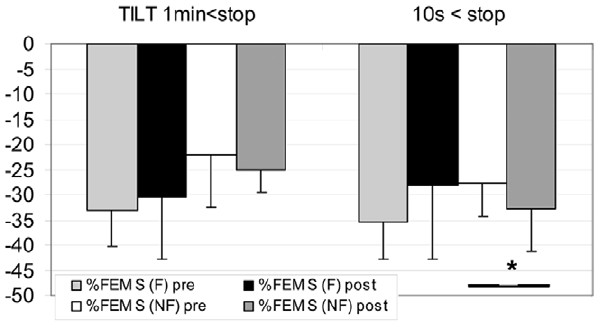
Figure 3. Percent decrease in FEM S (Femoral Systolic flow velocity) at 1 min and 10 s before end of Tilt (from supine) in F (finisher n=17) and NF (non finisher n=4). FEM S change proportionately with Aortic flow ie stroke volume. In F gr similar change pre/post HDBR at 1 min and 10 s. In NF gr Post HDBR FEM S flow velocity at 10 s before Tilt arrest drops more than pre HDBR (mean + / 2 SD, * P , 0.05).